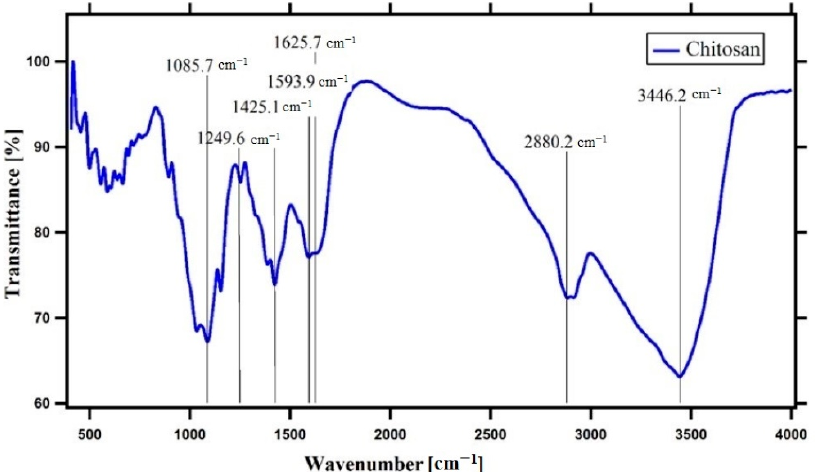
Figure 1. The Fourier transform infrared (FTIR) spectroscopy pattern of the used chitosan sample.